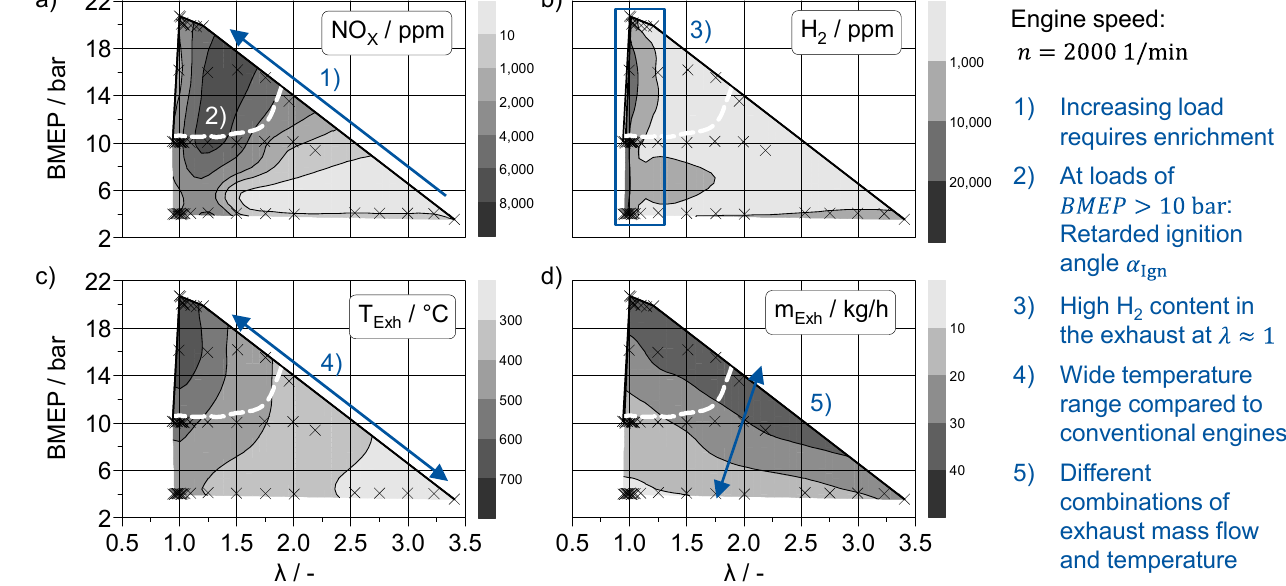
Figure 3. Characterization of the engine-out exhaust gas conditions as function of the air/fuel ratio λ : ( a ) Nitrogen oxide emissions, ( b ) Hydrogen content in the exhaust, ( c ) Exhaust gas temperature, ( d ) Exhaust gas mass flow. Measurement points at n = 2000 1/min are visualized as crosses. Measurements at other engine speeds also account into the interpolation, but as fourth dimension they cannot be displayed.